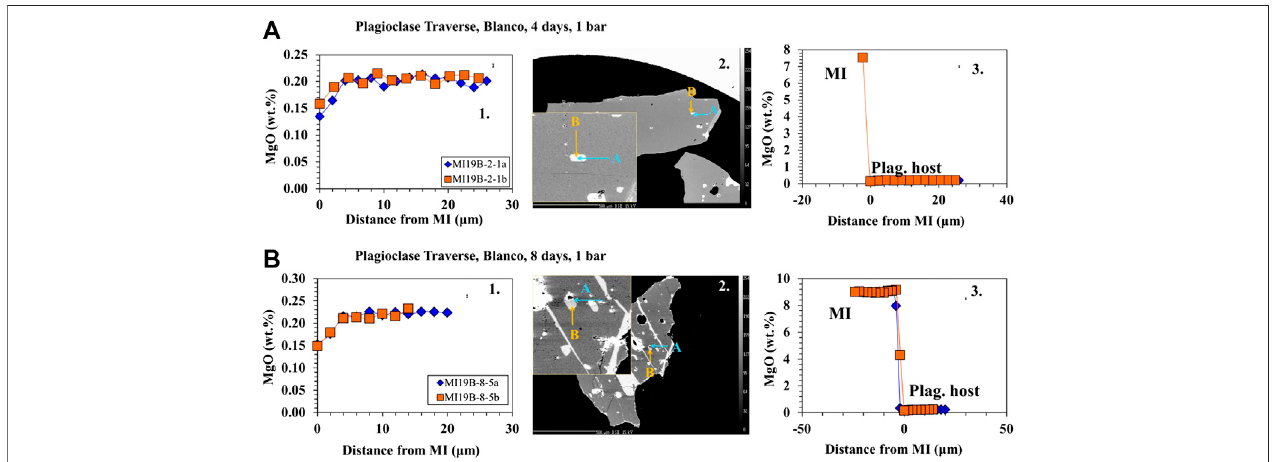
FIGURE4| Major element pro fi les between thehostplagioclaseand the MIforlowpressureexperiments. 1) Thepro fi le from theplagioclasehost(right)intothe MI (left) marked by an increase in MgO. Error bars are located in the upper right corner. 2) BSE images showing the direction and location of traverses. 3) Pro fi le within the plagioclase host as it approaches the boundary of the MI (marked by0 distance from MI). (A) Pro fi les and BSEon 4-day Blanco-A91-1R1 low pressure sample. Results show a decrease in MgO as the traverse approaches the MI boundary. (B) Pro fi les and BSE on 8-day low pressure Blanco-A91-1R1 sample. Results show a decrease in MgO as the traverse approaches the MI boundary. The bands of melt (light grey) across the crystal (medium grey) represent melt present along fractures, presumably cleavage planes. A number of other breached MIs are present in the same image.